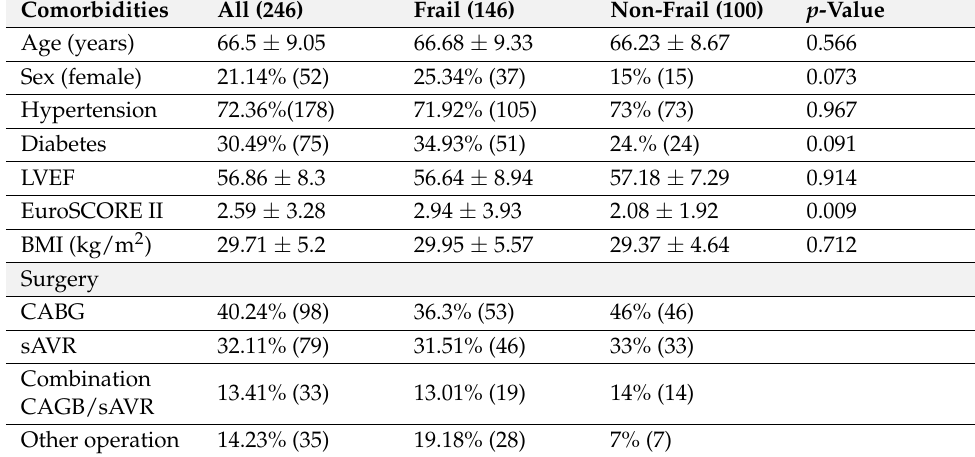
Table S1. Table 1. Comorbidities and type of